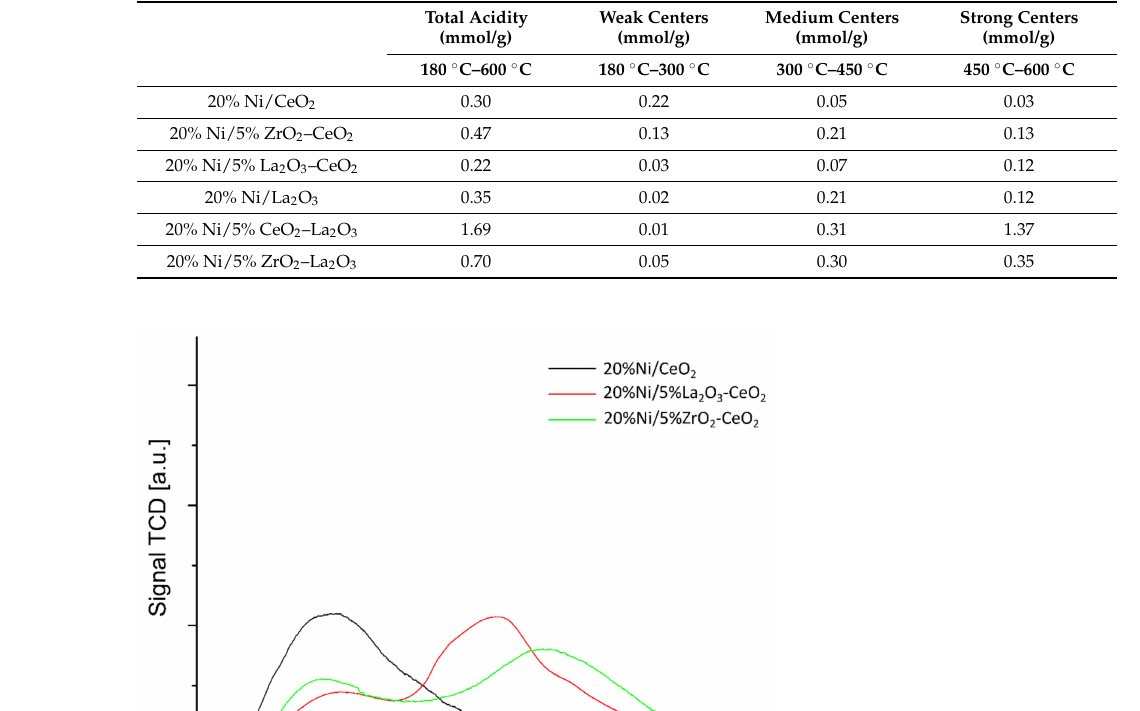
Table 2. The amount of NH 3 adsorbed on the surface of monometallic supported nickel catalysts reduced at 500 ◦ C in pure hydrogen for 1 h, calculated from the surface under the peaks recorded during the TPD-NH 3 measurements.